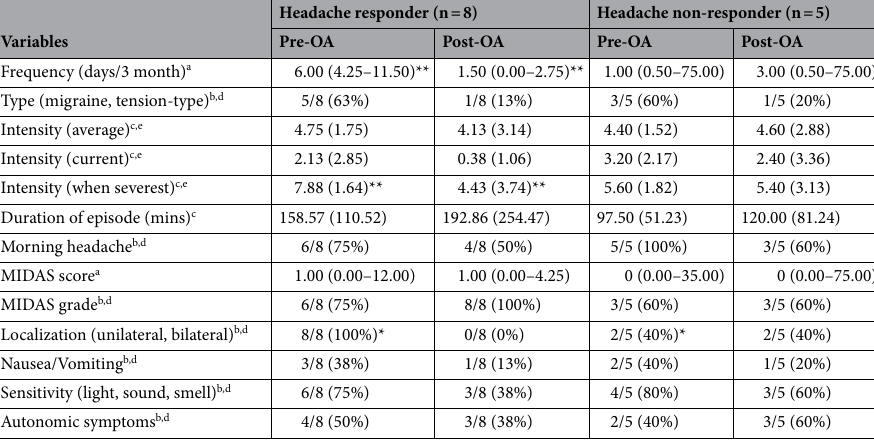
Table 2. Headache characteristics according to headache responder group. Grouping was based on ≥ 30% reduction in headache frequency. OA oral appliance. *Significant difference: P < 0.05, comparison between headache responder and non-responder. **Significant difference: P < 0.05, comparison between pre- and post-oral appliance treatment. a Differences between groups were tested with Mann–Whitney test and pre- and post-OA data were tested with Wilcoxon Rank-sum test: Median (lower quartile-upper quartile). b Differences between groups were tested with Chi-square test and pre- and post-OA data were tested with McNemar’s test. c Differences between groups were tested with t-test and pre- and post-OA data were tested with paired t-test: Mean (SD). d Results given as number of patients with migraine, morning headaches, low disability, bilateral headache, nausea (vomiting), sensitivity, autonomic symptoms/total number of patients (percentage of patients with each characteristic). e Based on a visual analog scale, 0 (no pain) − 10 (worst pain imaginable).